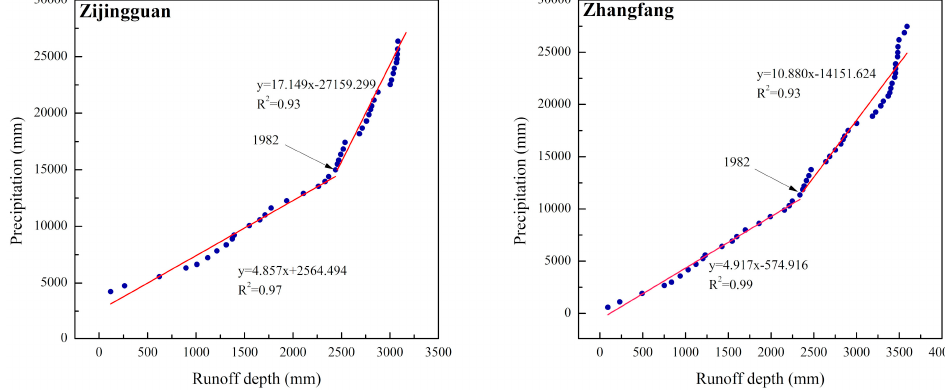
Figure 5. Pettitt tests for time series of measured annual runoff ( a – b ) and restored annual runoff ( c – d ).